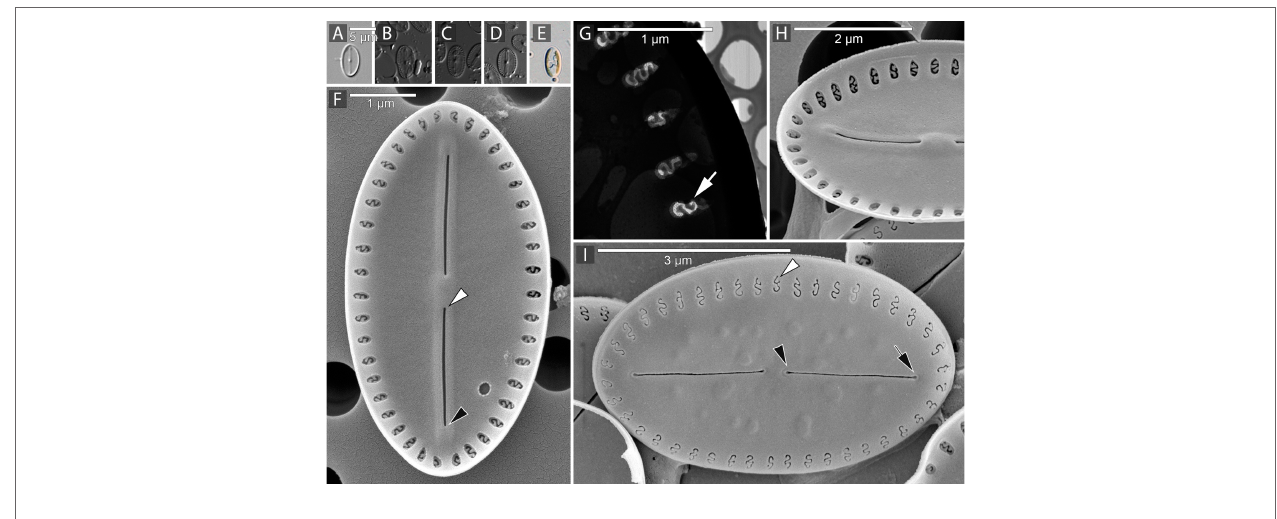
FIGURE 2 | Amicula vermiculata Chunlian Li, Frankovich, Wachnicka & Witkowski sp. nov. Figure (A) . Light microscopic image of a wild specimen of A. vermiculata . Figures (B–D) . LM image of the specimens from culture (strain SZCZCH282). Specimen in Figure (D) is selected as the holotype. Figure (E) is a live specimen from the culture. Figures (F, H, I) . SEM images of A. vermiculata . Figure (G) . Close up of A. vermiculata from culture imaged with TEM. Figure (F) . Internal view of a specimen from natural sample. Note the internal raphe branches with internal central raphe end (white arrowhead) and apical raphe end with very small helictoglossa (black arrowhead). Figure (G) . Close up of the internal valve view illustrating the hymenate areola occlusion (white arrow). Figure (H) . Internal view of the specimen from the culture. Figure (I) . External view of the specimen from culture; note the cribrate areola occlusions (white arrowhead) and the short raphe branches with external central raphe ends (black arrowhead) and external apical raphe end (black arrow).